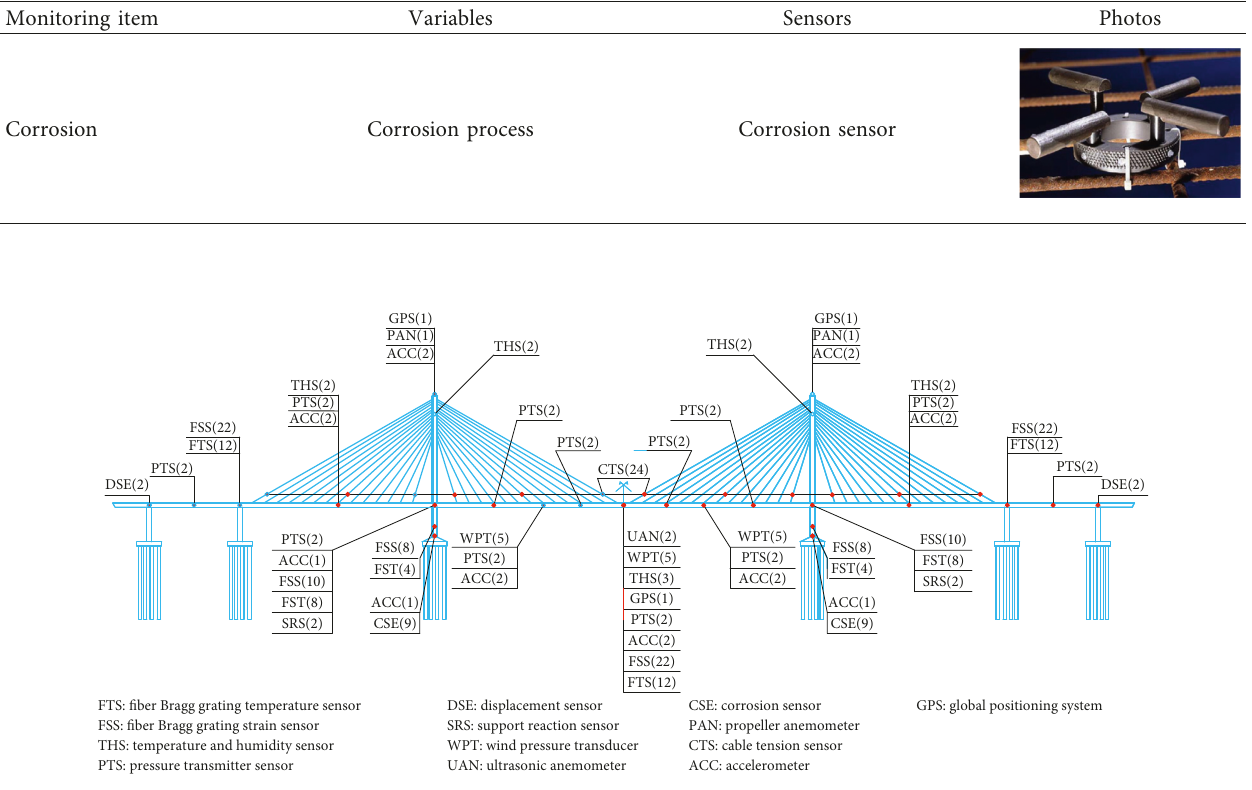
Figure 7: General layout of the sensors on the Qingzhou Shipping Channel Bridge. Table 2: Data analysis methods [5,